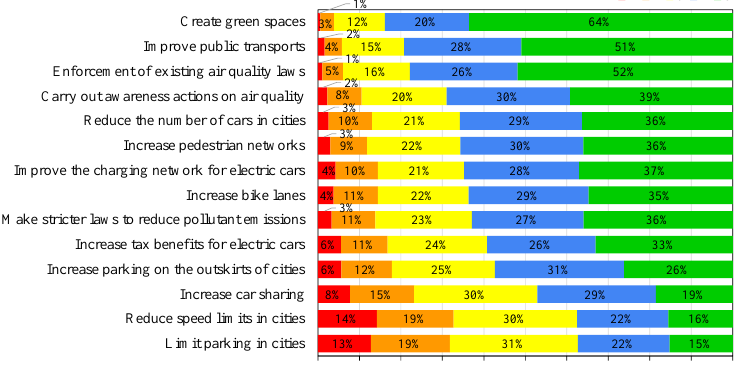
Figure 12. Degree of priority given by the citizens of the general population to different measures to improve air quality (ranging from 1 for “minimum priority” to 5 for “maximum priority”).